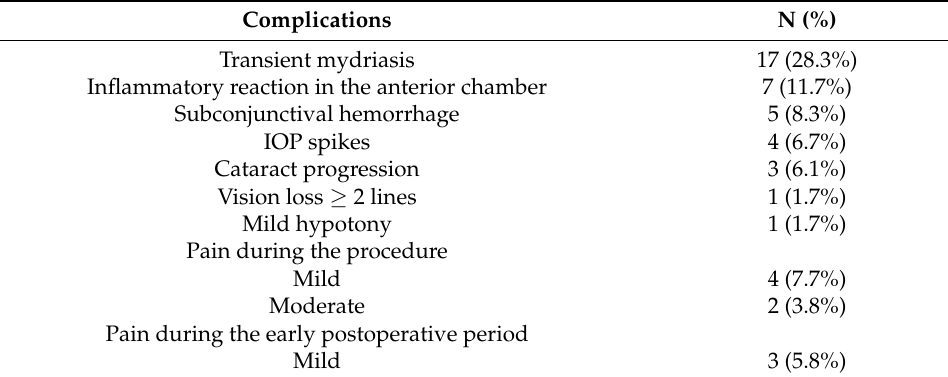
Table 7. Summary of the complications following MP-TSCPC during the follow-up